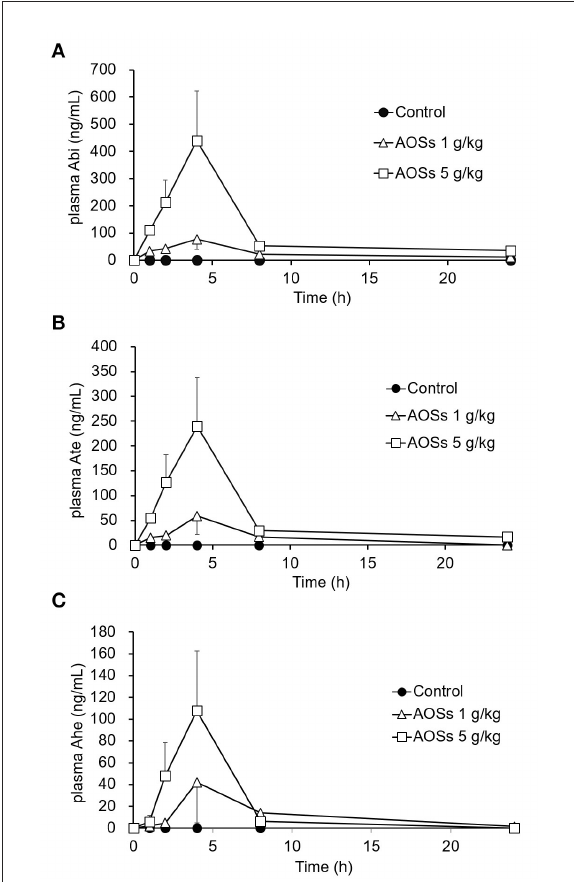
FIGURE2 Plasma concentration–time profiles of Abi (A) , Ate (B) , and Ahe (C) after oral administration of AOSs to rats. Each value represents the mean ± standard error (SE) ( n =